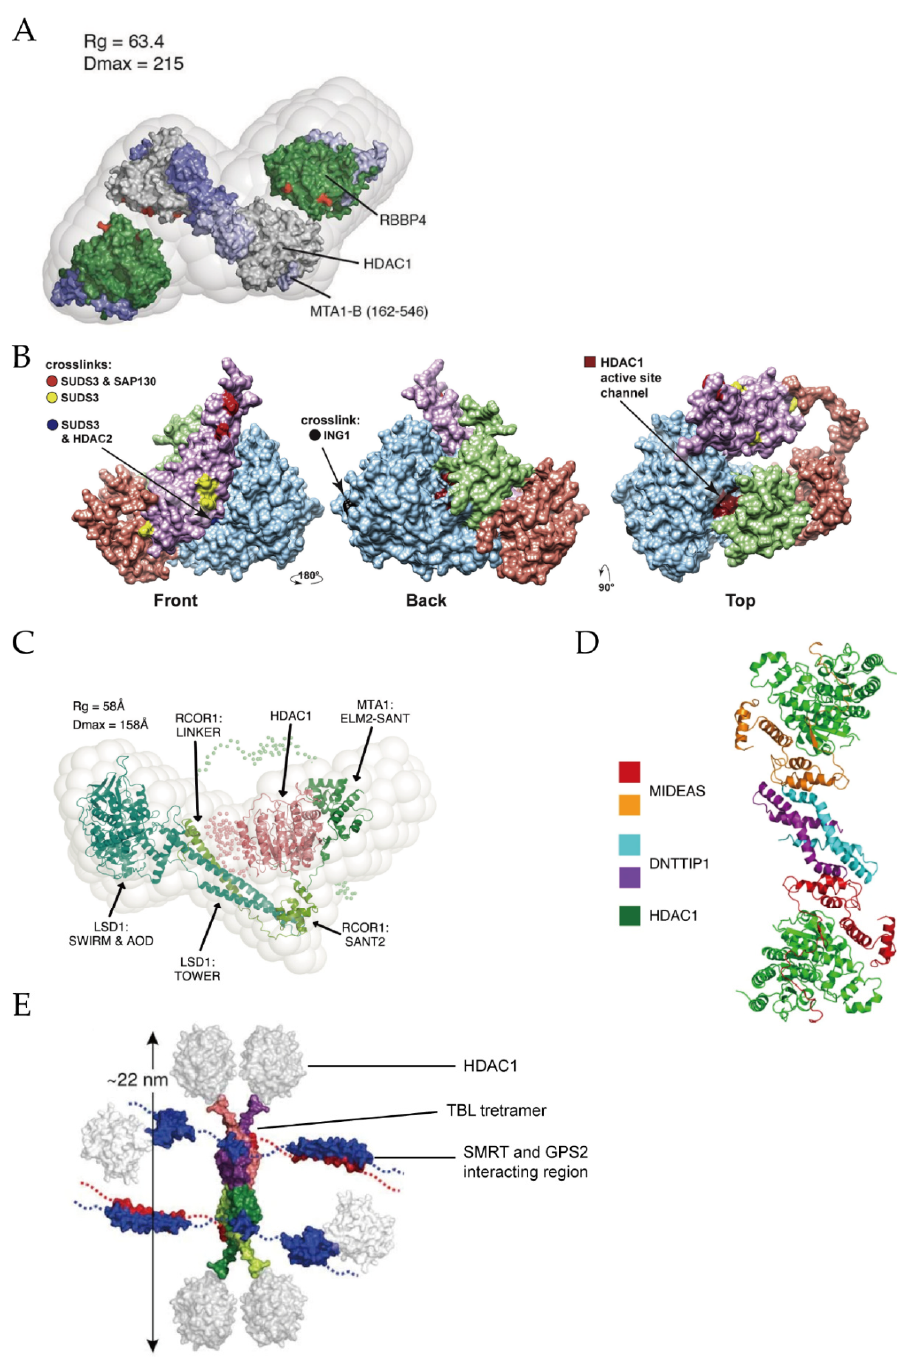
Figure 4. ( A ) Structure of the core NuRD complex (HDAC1 / RBBP4 / MTA1 (162-546)). Adapted